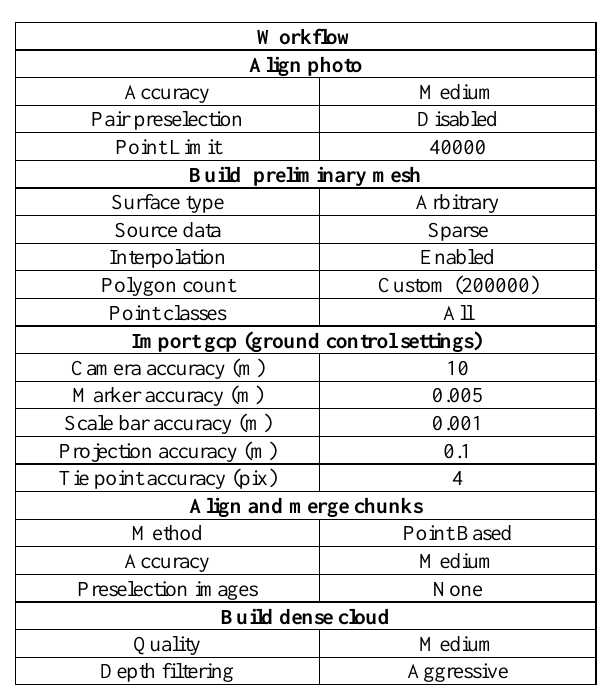
Table 1. Parameters and workflow used in Agisoft PhotoScan Three different data sets were selected, which correspond respectively to a 80%, 60% and 40% overlapping of the aerial images. The point clouds were realized by a separate processing of the data sets. Each point cloud was compared with the